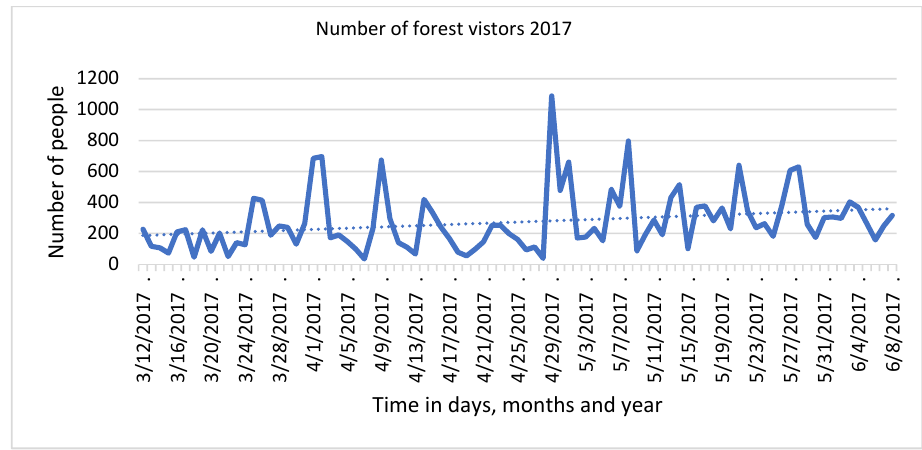
Figure A3. Recorded number of visitors per day in three months in 2017.